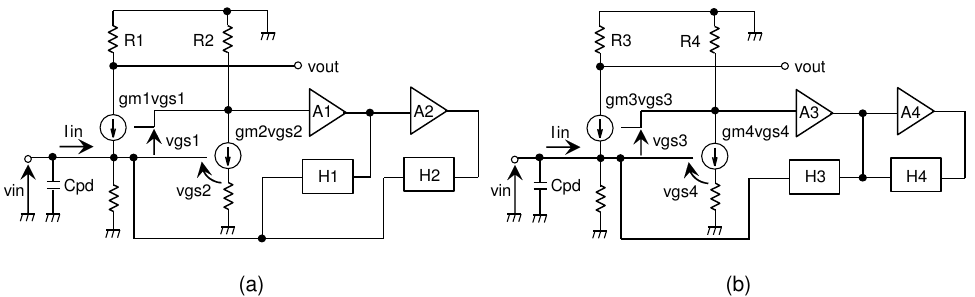
Figure 6. Small-signal equivalent circuit: ( a ) conventional multi-feedback stage RGC TIA, ( b ) pro- posed RGC